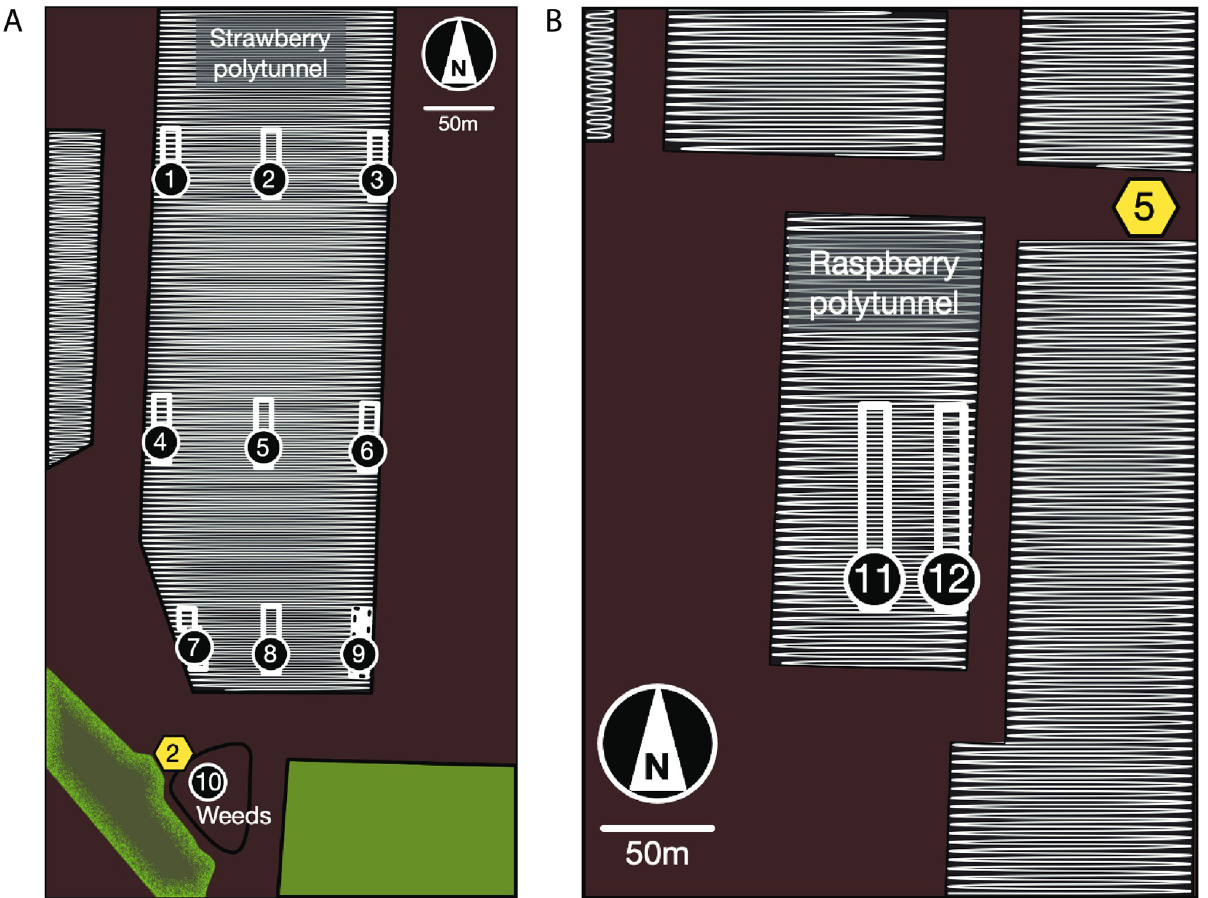
Fig 5. Detailed plan of study site. (A) Strawberry polytunnels and (B) raspberry polytunnels (refer to Fig 1 for site overview). Numbers/rectangles indicate locations of insect quadrat observations and pan-traps under the polytunnels #1–9, #11–12, and #10 in the weeds. The white-black dashed rectangle (location #9) additionally shows the location of the camera observations to record detailed insect- strawberry flower interactions. Managed honeybee hives (yellow hexagons) with the number of hives at locations close to study sites are indicated.